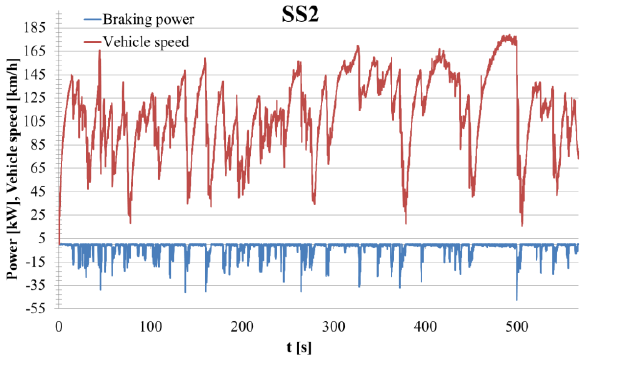
Fig. 7. Braking energy in SS1